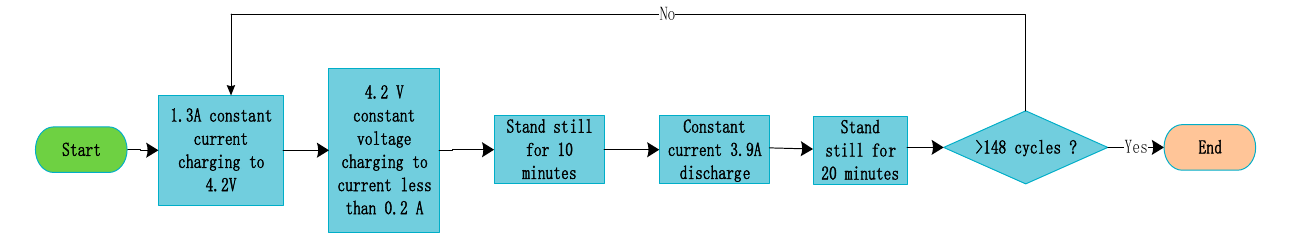
Figure 2. Experimental process.